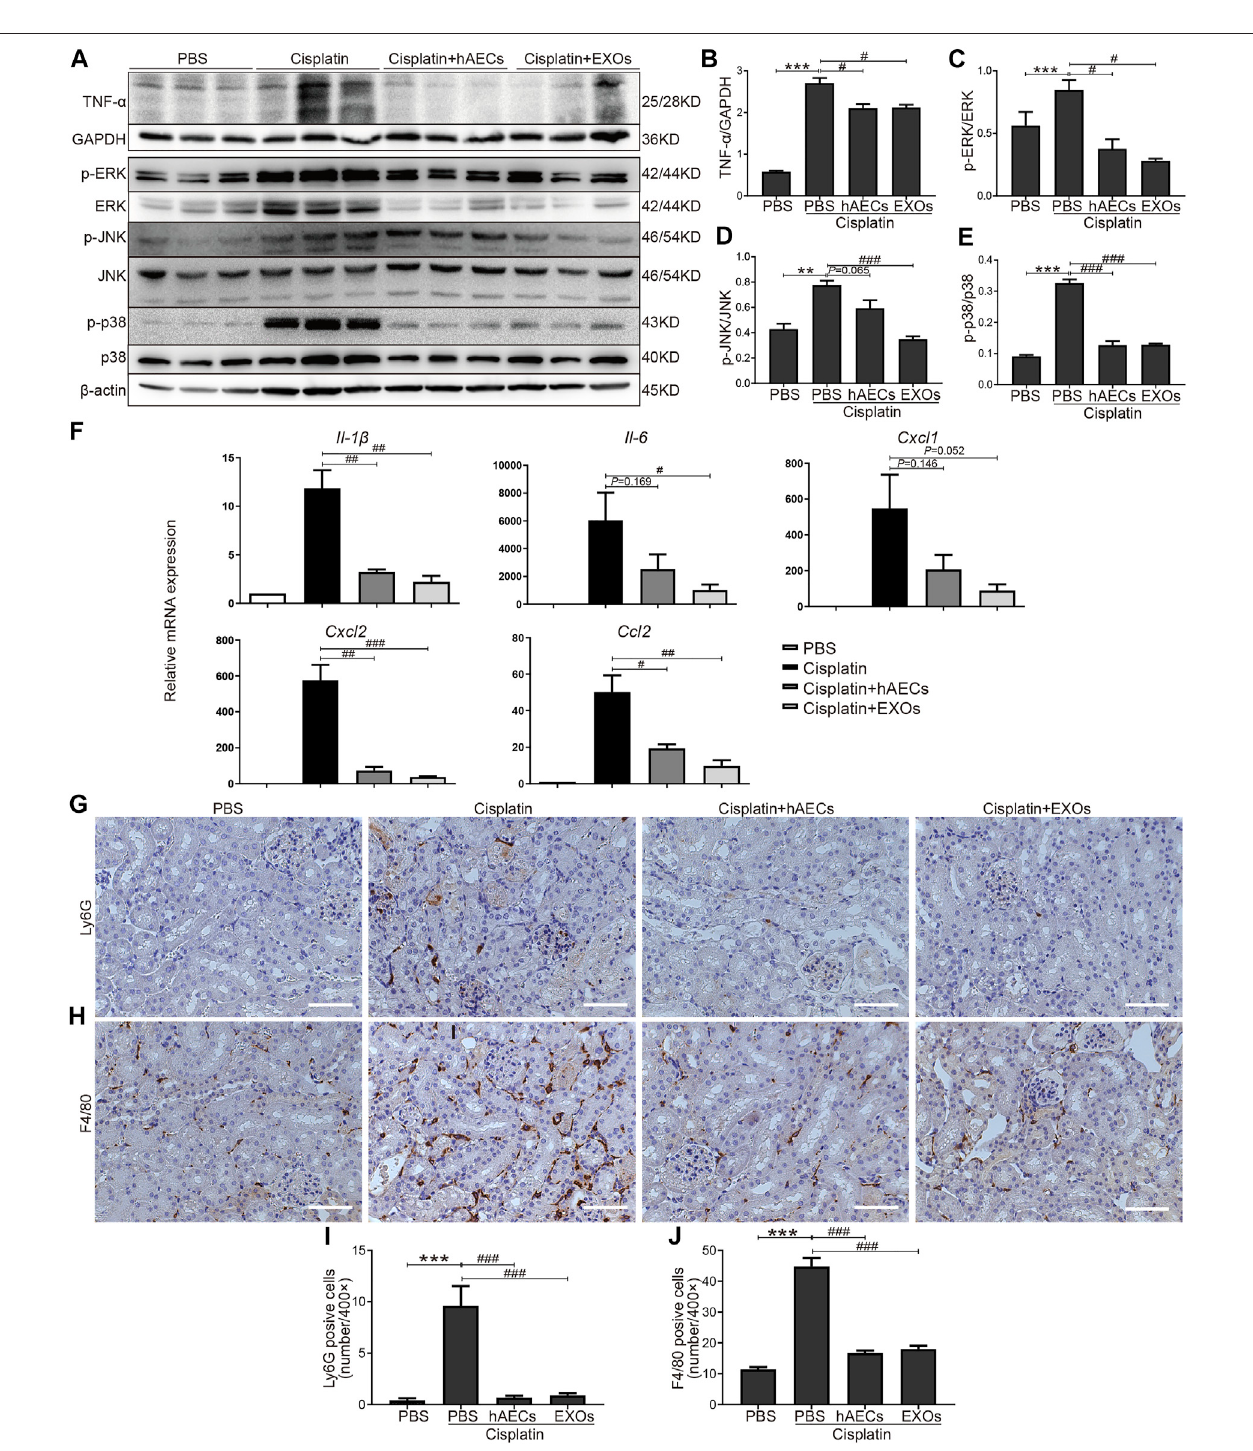
FIGURE 3 | Regulation of TNF- α /MAPK pathway by hAECs and EXOs in C57BL/6J mice treated with 15 mg/kg cisplatin. (A) Representative Western blots showing protein expression of TNF- α , p-ERK, ERK, p-JNK, JNK, p-p38, and p38 of kidneys in different groups as indicated. (B – E) The relative protein expression of TNF- α to GAPDH, p-ERK to ERK, p-JNK to JNK, and p-p38 to p38 in different groups ( n (cid:1) 3). (F) The relative mRNA expression of Il-1 β , Il-6 , Cxcl1 , Cxcl2 , and Ccl2 determined by RT-PCR. (G,I) Representative micrographs and quanti fi cation of Ly6G positive staining on kidney sections of different groups as indicated. (H,J) Representative micrographs and quanti fi cation of F4/80 positive staining on kidney sections of different groups as indicated. Scale bar, 100 μ m n (cid:1) 3 for each group. Data are shown as mean ± SEM. ** p < 0.01 and *** p < 0.001 vs. PBS group, # p < 0.05, ## p < 0.01, and ### p < 0.001 vs. cisplatin group.